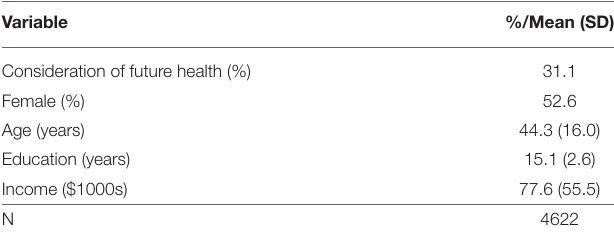
TABLE 1 | Summary statistics on consideration of future health impacts during food choice and demographic characteristics of US